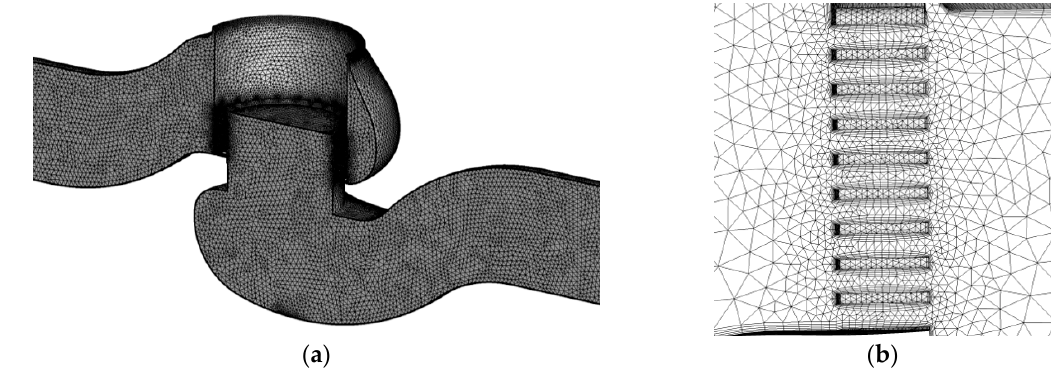
Figure 2. Mesh of the sleeve regulating valve with maximum valve core displacement of 60 mm ( a ) overall view; ( b ) mesh in the sleeve.